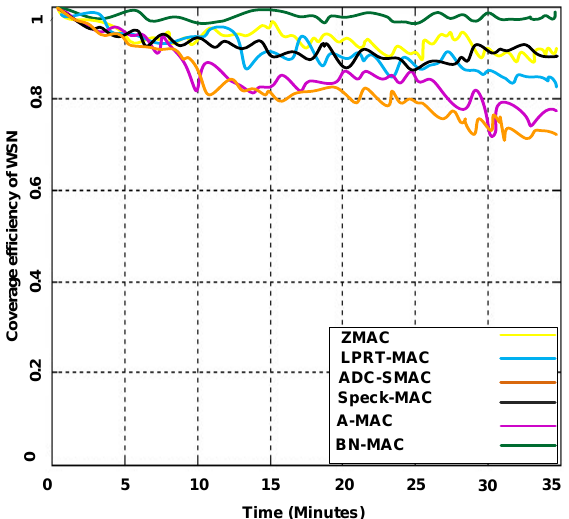
Figure 15. Coverage efficiency of the network at different